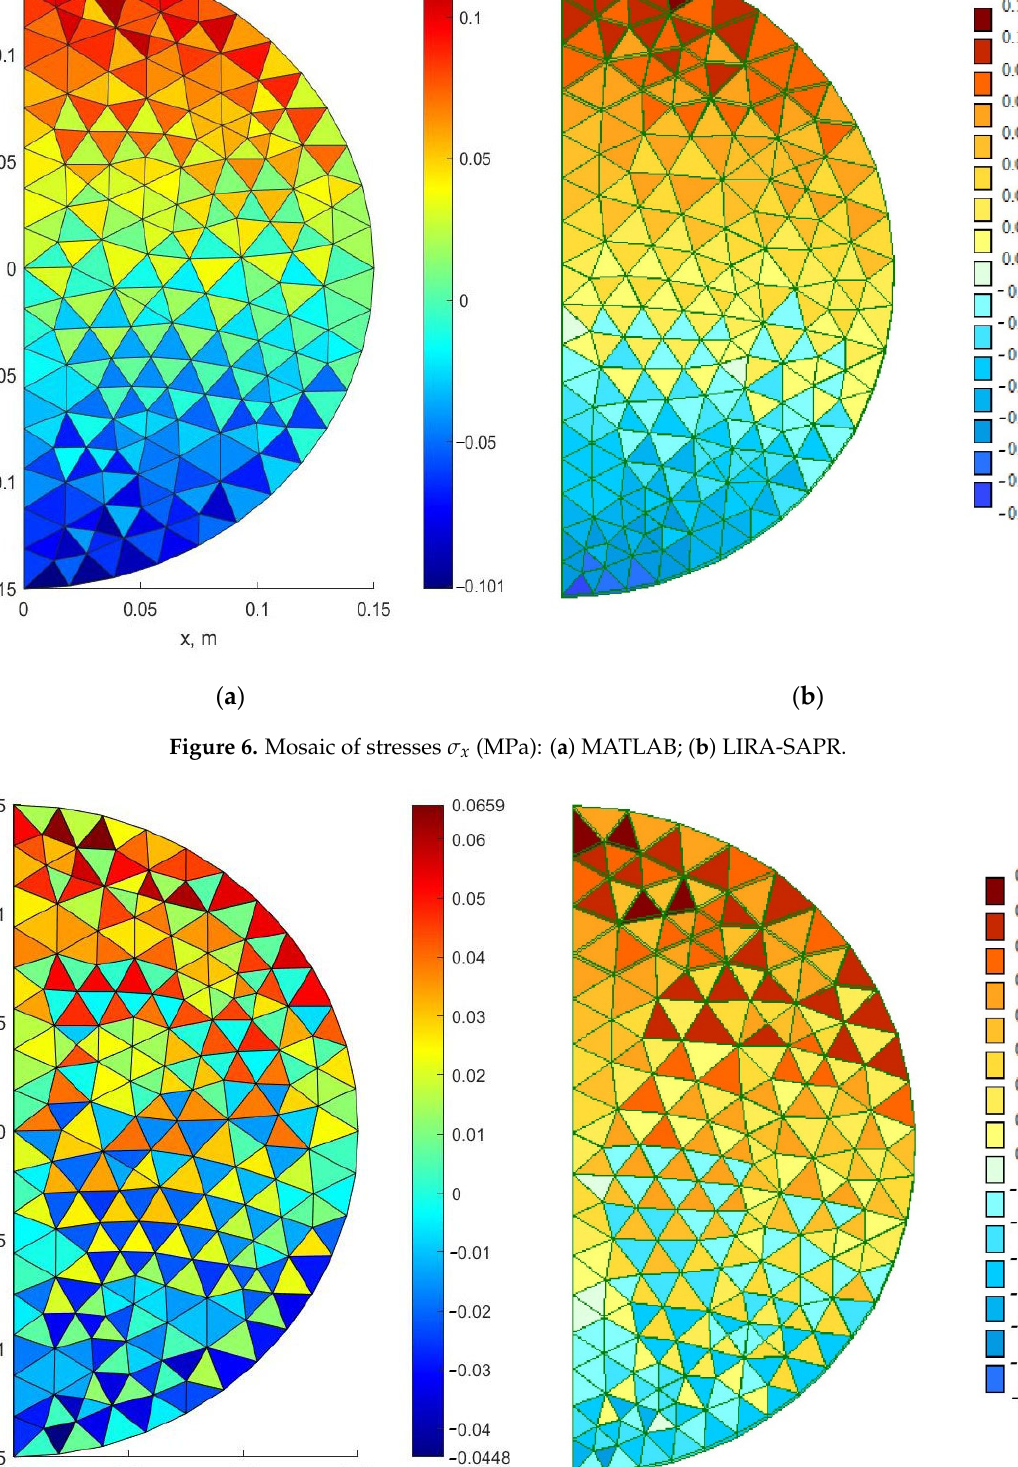
Figure 5. Mosaic of stresses σ z (MPa): ( a ) MATLAB; ( b ) LIRA-SAPR.